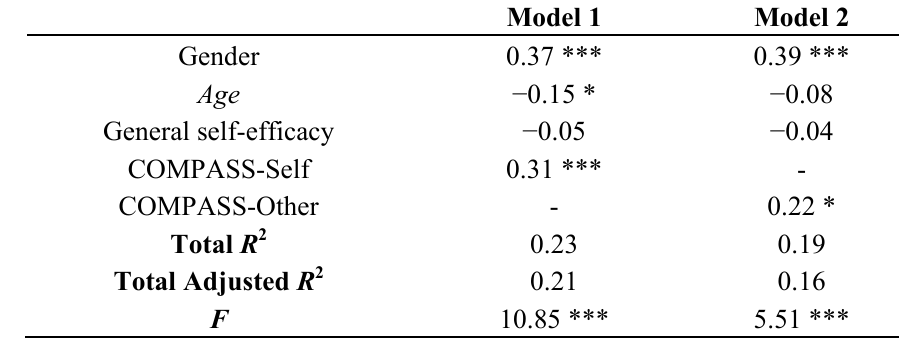
Table 3. Multiple linear regression analyses examining association between baseline characteristics, self ( n = 166—Model 1) or other ( n = 153—Model 2) rated COMPASS-diet score and weight loss achieved at the end of the intervention